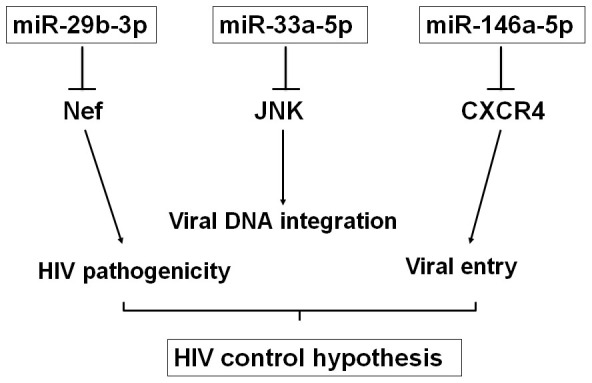
MiRNAs differentially expressed between EC and CH target genes with important functions in HIV cycle.Hypothetical figure showing how hsa-miR29b-3p, hsa-miR33a-5p and hsa-miR146a-5p could affect the replication of HIV.